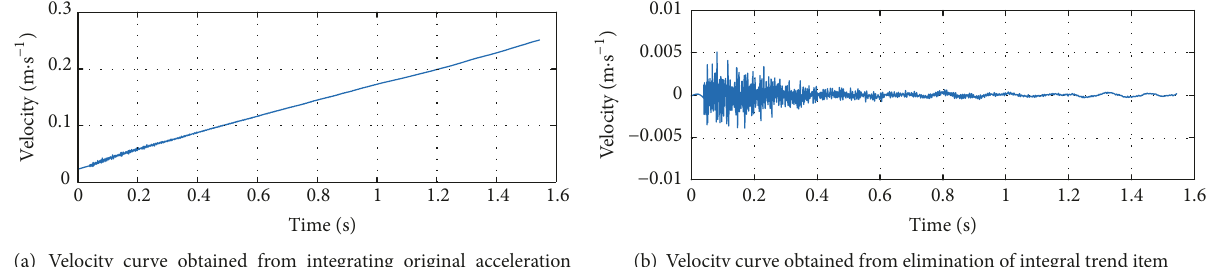
Figure 5: Vibration velocity curve at inner surface of explosive vessel.